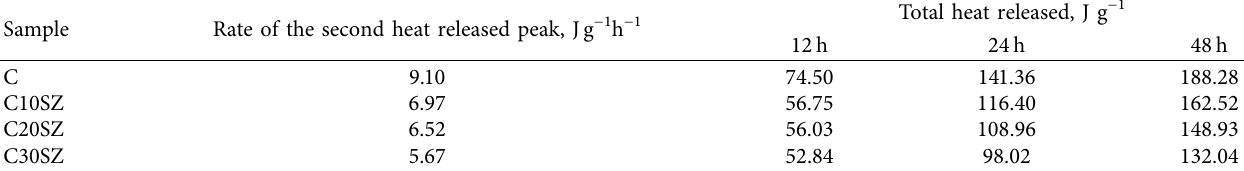
Table 4: Rate of the second heat released peak and total heat released of samples at 20 ° C. Sample